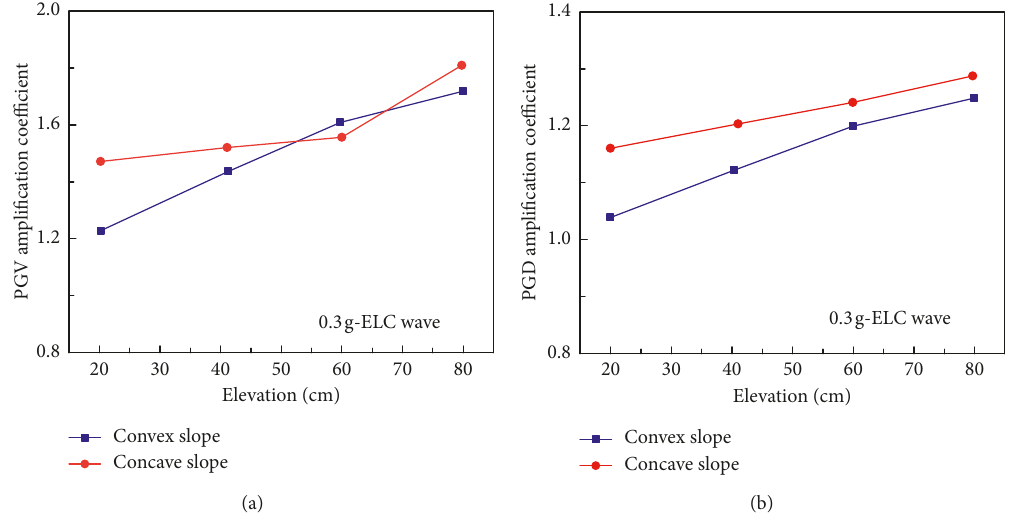
Figure 11: Variation curves of (a) PGV and (b) PGD amplification coefficient.